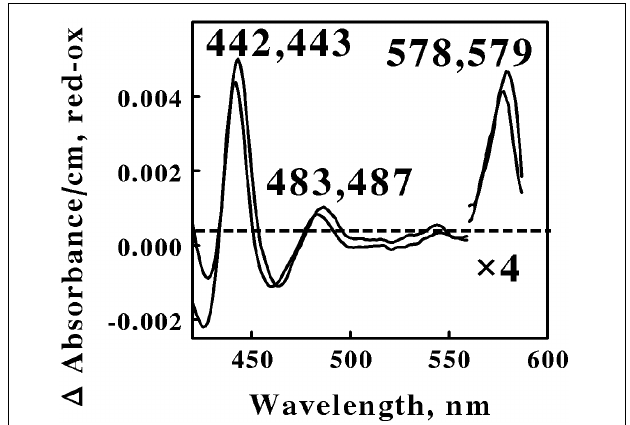
FIGURE 5 | Reduced minus oxidized difference spectra obtained when excess ferrous sulfate was mixed with intact cells of Metallosphaera sedula (lower wavelengths) and Sulfolobus metallicus (higher wavelengths), representing the Crenarchaeota. The number of cells present in 8 ml were 7.3 × 10 10 and 1.2 × 10 11 for M. sedula and S. metallicus , respectively. The absorbance values in the α regions of both spectra were multiplied by 4 to aid in the clarity of